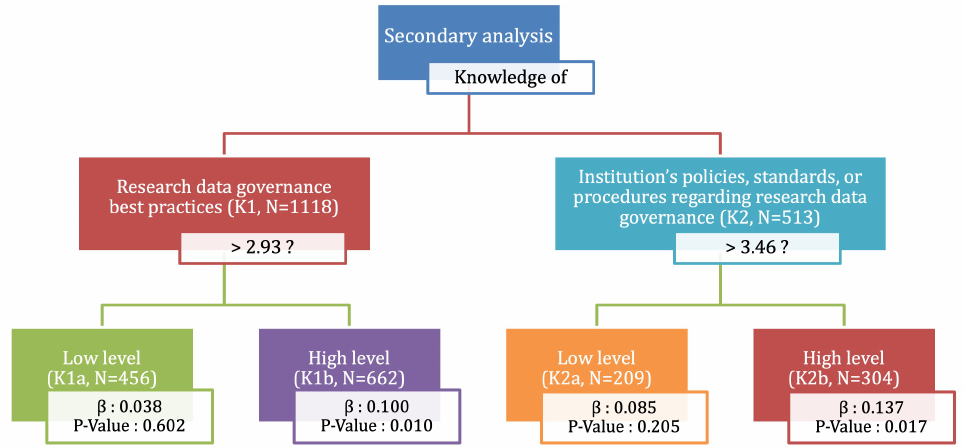
Figure 10. Secondary analyses of the effect of attitudes on data governance behavior for groups with different levels of